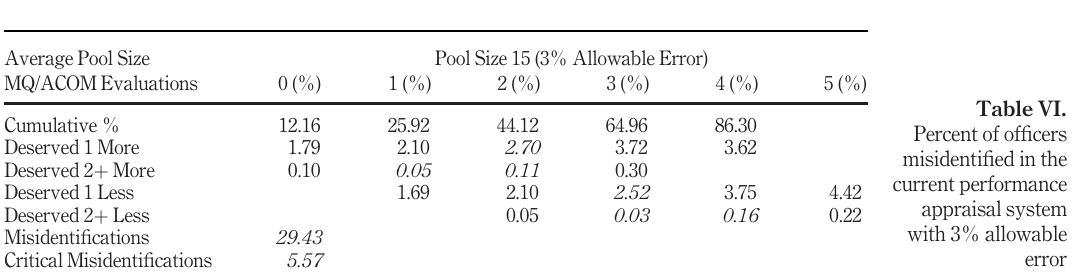
Figure 7. Percent of of fi cer misidenti fi cations and critical misidenti fi cations when varying the average pool sizes